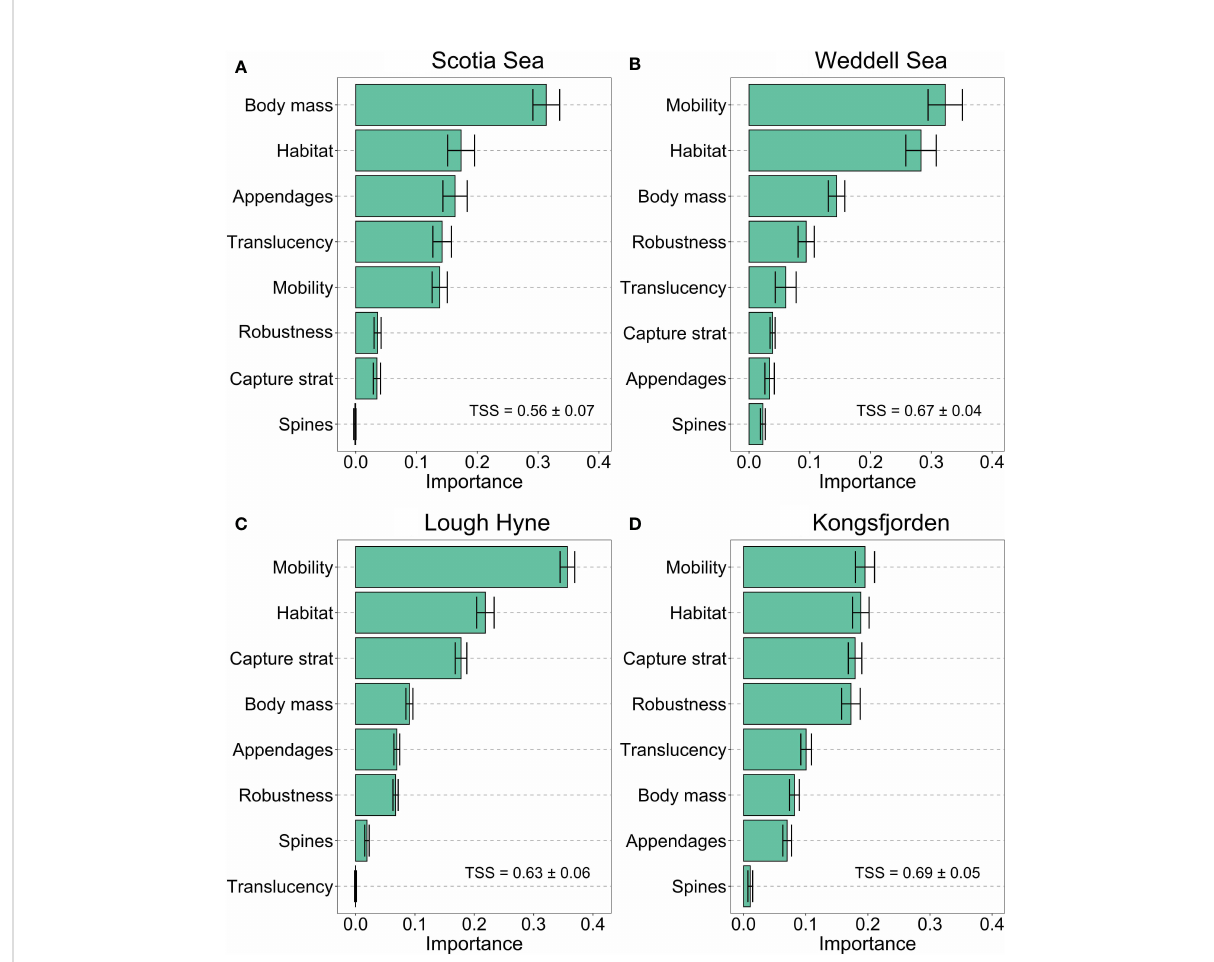
FIGURE 5 Relative importance of each functional trait (as a proportion of the summed importance of all traits) for classifying species into modules, as identi fi ed by Random Forest models for each network: (A) Scotia Sea; (B) Weddell Sea; (C) Lough Hyne; (D) Kongsfjorden. Error bars are the 95% con fi dence intervals resulting from 20 cross-validations of the importance of each trait. True Skill Statistics (TSS) values indicate the predictive performance of the